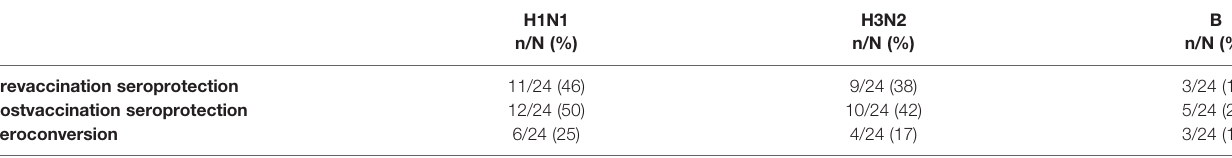
TABLE 3 | Pre- and postvaccination rates for seroprotection